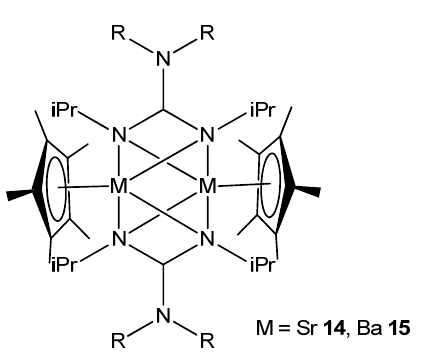
Figure 10. Dinuclear strontium and barium compounds with guanidinato chelate and bridging ligands.